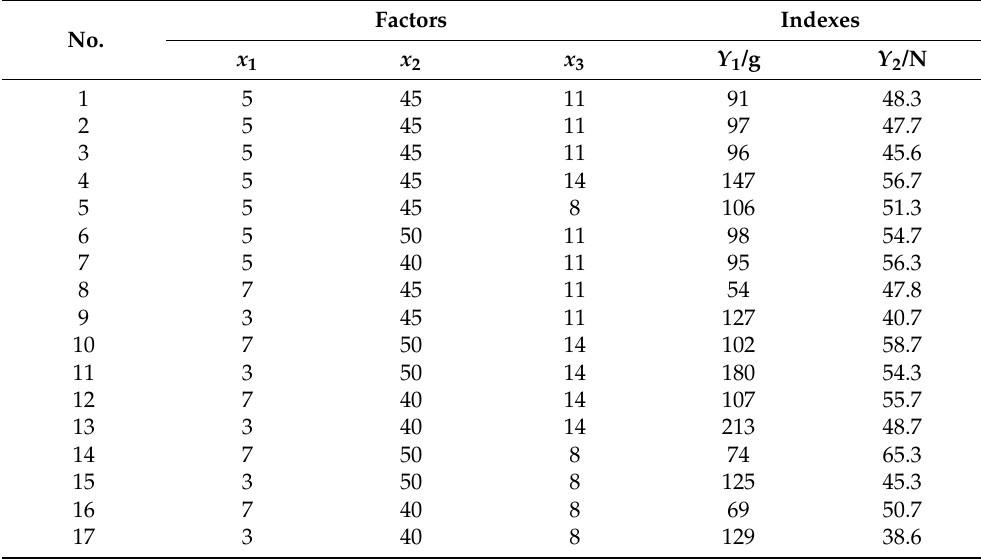
Table 3. Test schemes and results for the central composite face − centered method. Table 2. Experimental factors and levels for the central composite face-centered method.